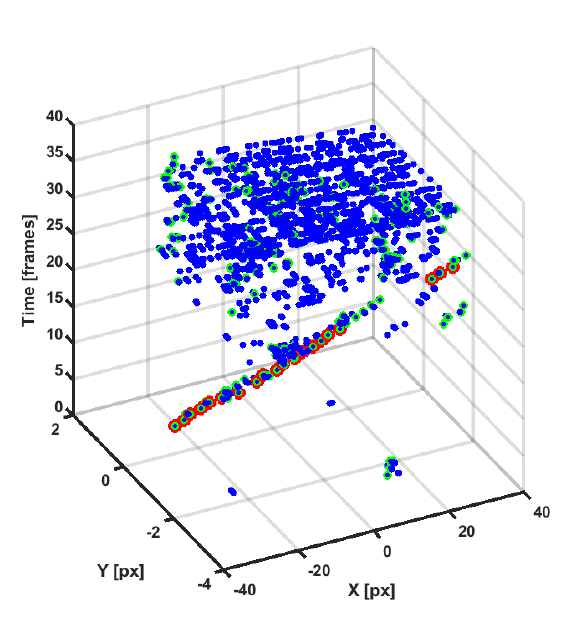
Figure 8. Peak pairs from the 1D intensity analysis of Fig. 6 over all time frames are triangulated to yield a cloud of points. These points (blue dots) are sorted into 4D space (3D + time). Here the Z component is omitted. Points within a distance r max from the trajectory are shown in green. Points near the trajectory that are also consistent in time are found with RANSAC and plotted in red. Red points are the true fragment